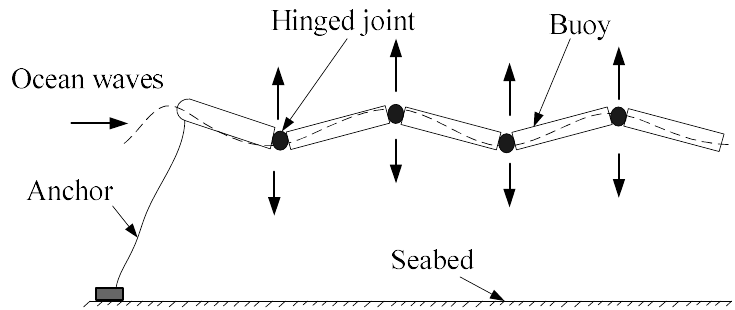
Figure 5. Structure of the Pelamis.